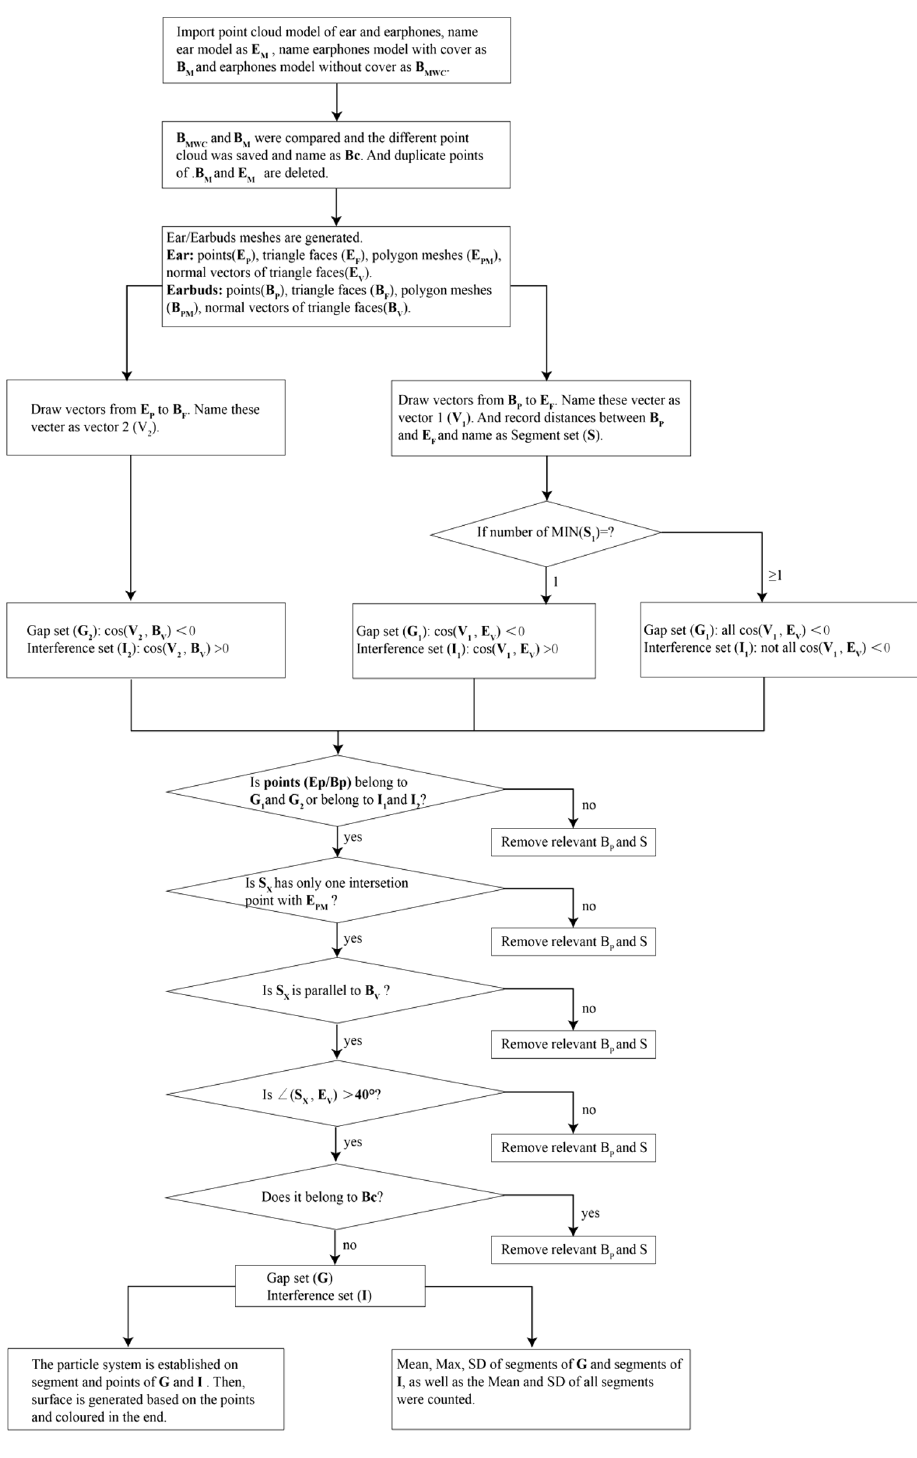
Figure 4. Flow chart of deviation analysis